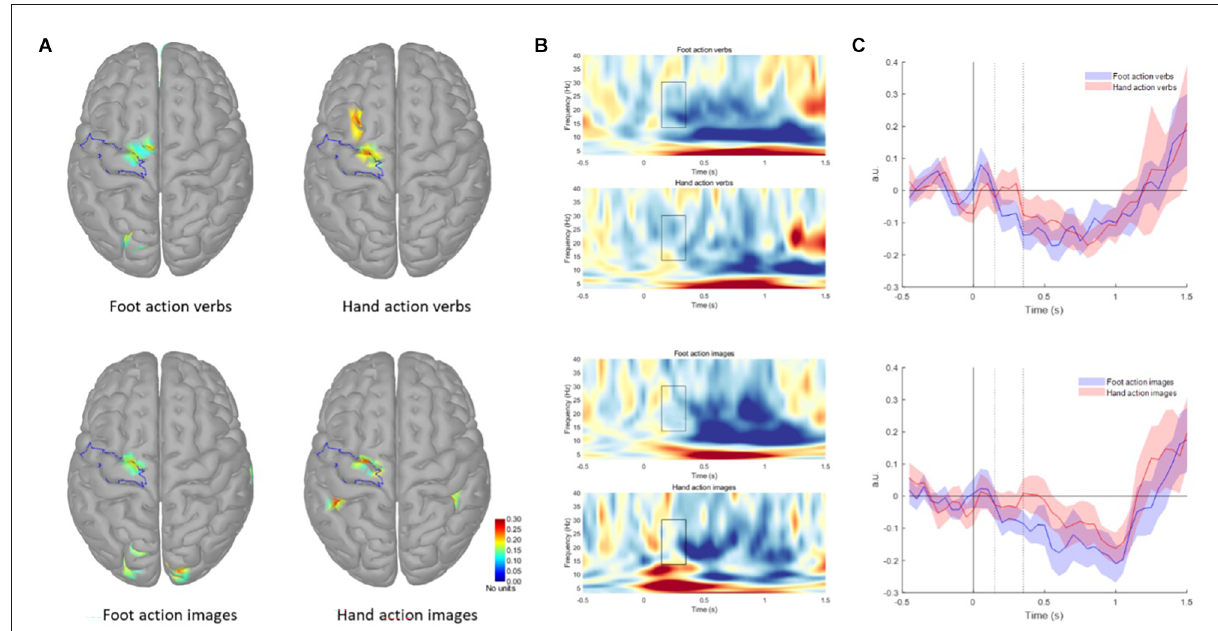
FIGURE2 (A) Grand average maps of responses to different categories of stimuli in the 150–350 ms period. The highlighted area represents the ROI used for the analysis. The color scale is the same for each map (0–0.3); for illustrative purposes, maps were thresholded at 50% of the maximum amplitude. (B) Time-frequency representation of the virtual channel obtained from the ROI for each condition. The highlighted area represents the time and frequency interval selected for the analysis. The color scale is the same for each image ( − 0.3–0.4). (C) Beta band modulation with respect to baseline ( − 1–0 s) for verbs (upper graph) and images (lower graph) stimuli. Shaded areas indicate the standard error of the mean. Dotted lines indicate the period for AuC calculation, gray dotted line refers to the go